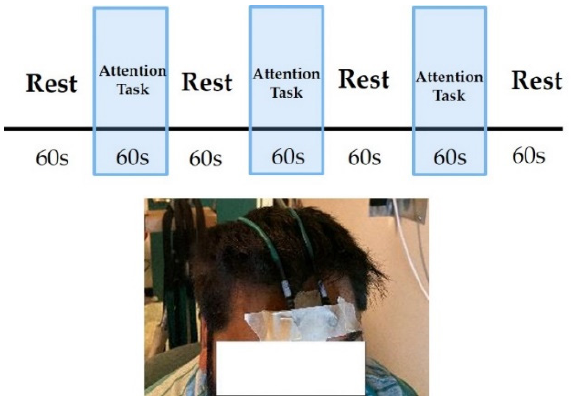
Figure 13. The attention test protocol and SCISCCO probe location. The excitation and receiving fibers were placed with 3 cm of separation on the forehead.